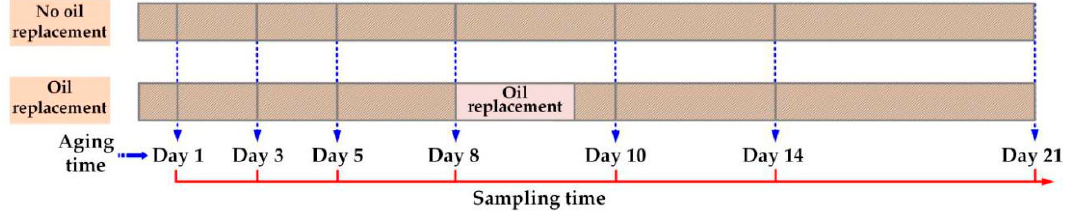
Figure 2. The specific sampling time points.